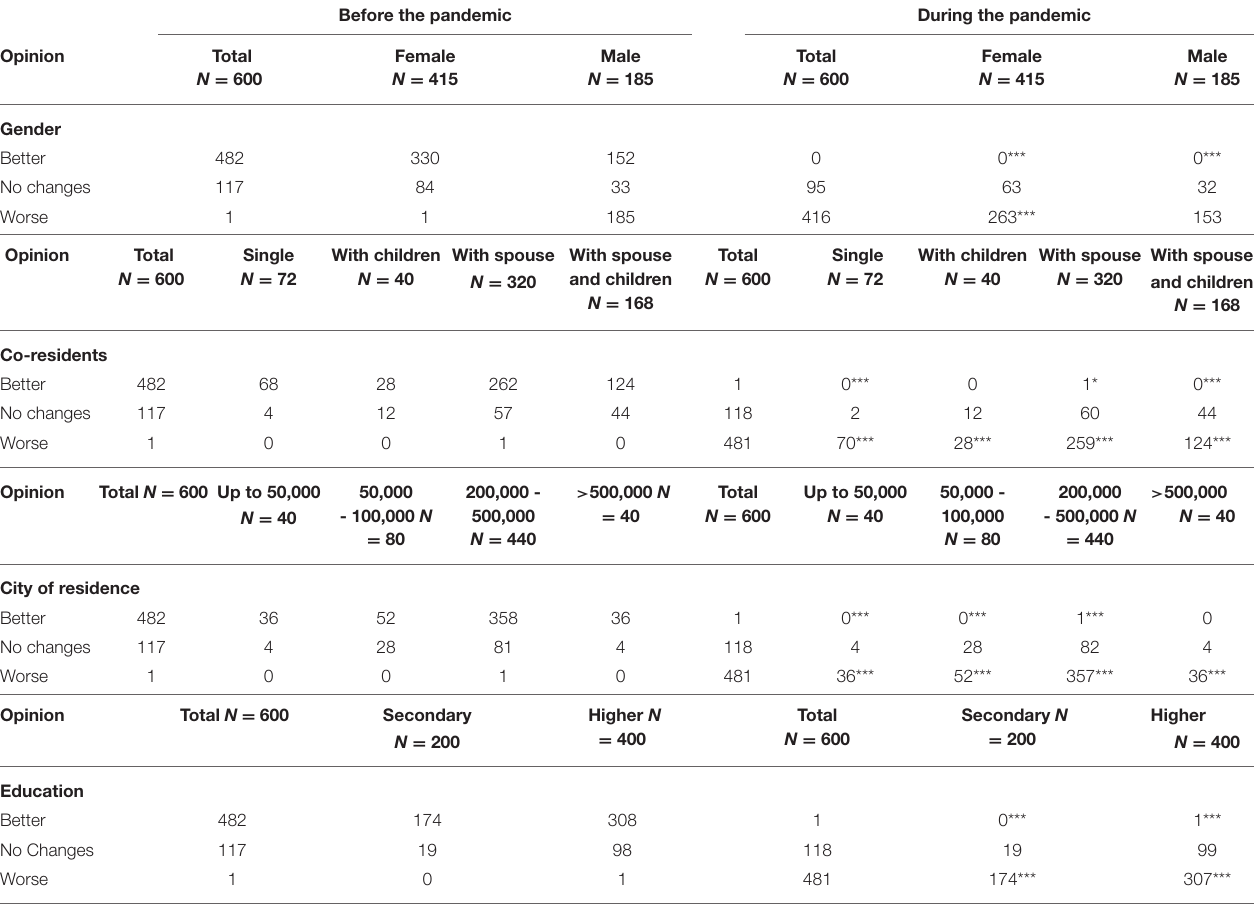
TABLE 1 | Respondents’ assessment of their health status – before and during the pandemic. Before the pandemic During the